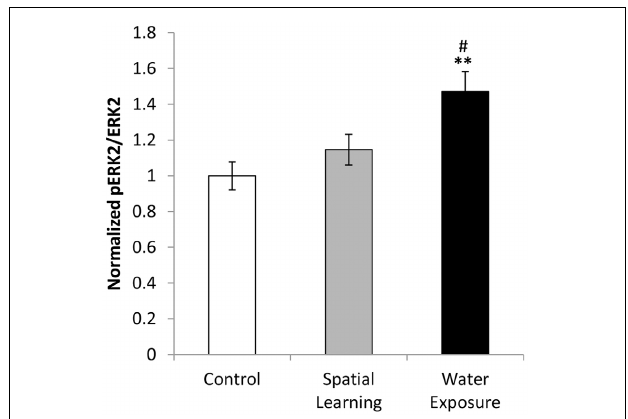
FIGURE 4 | BLA activation by water exposure stress without the possibility of spatial learning. While water exposure alone increased activation of the BLA as indicated by enhanced levels of ERK 1/2 phosphorylation, no such effect was observed after by providing an invisible platform enabling for spatial learning. Values are mean ± s.e.m. for normalized optical density (arbitrary units). ∗∗ Significant difference from Control with p < 0 . 01; # significant difference between Spatial Learning and Water Exposure groups with p < 0 .